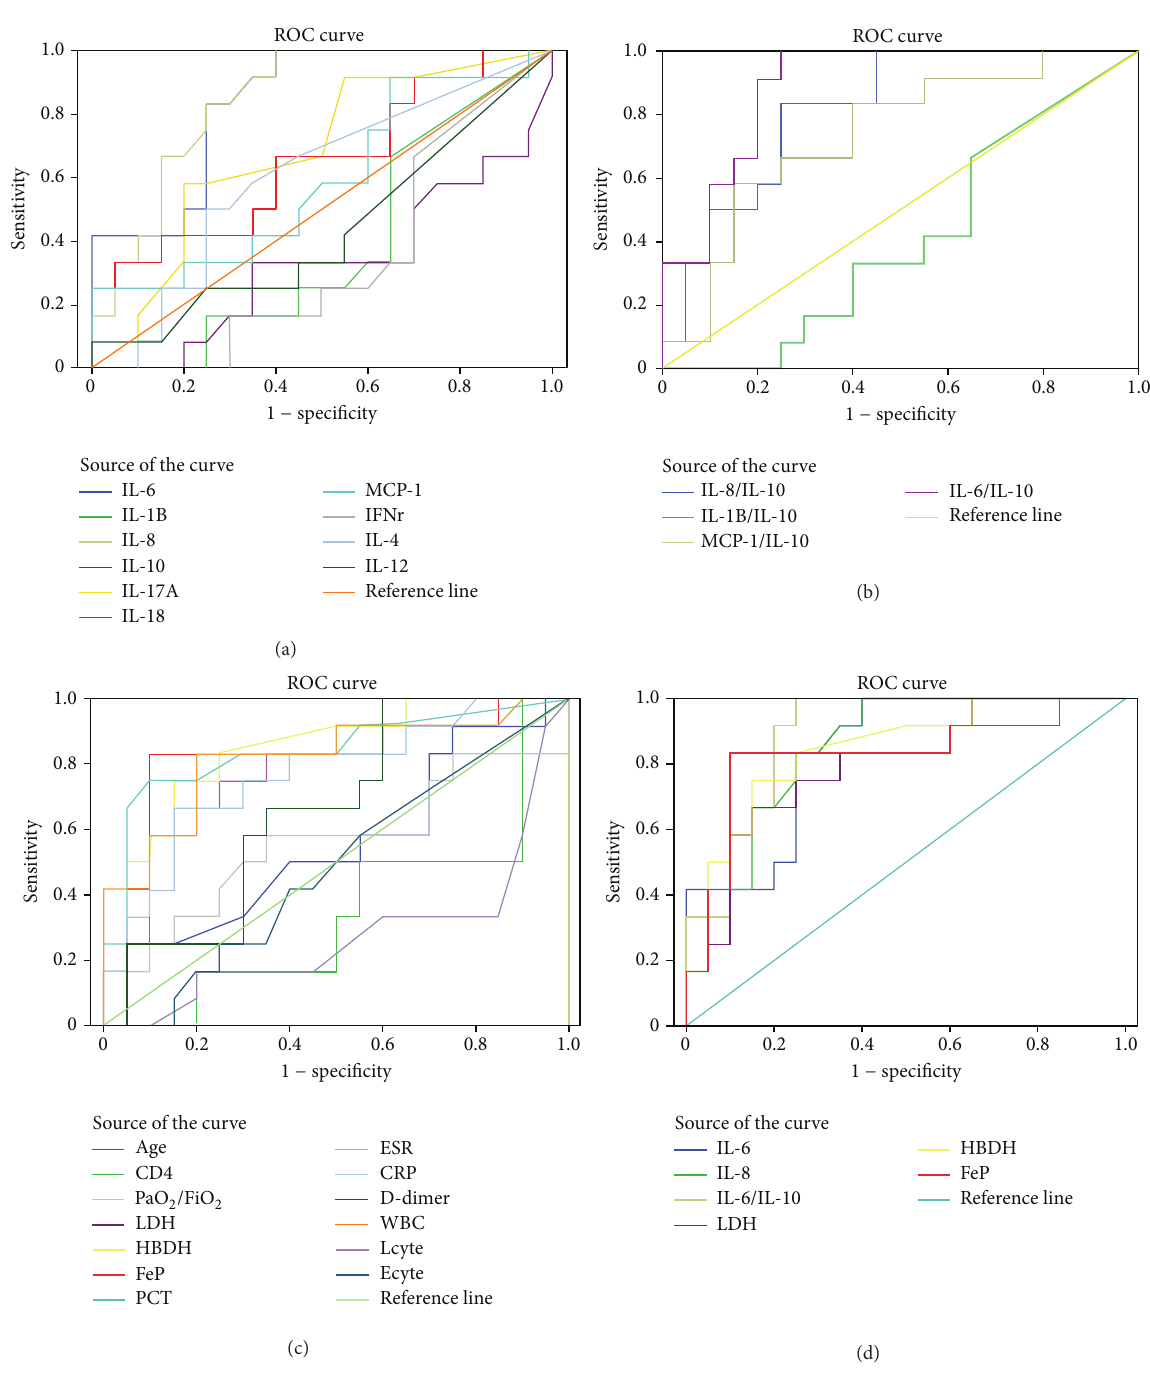
Figure 2: Receiver operating characteristic (ROC) curve analysis of biomarkers in lighter severity (PaO 2 /FiO 2 ≤ 200 mmHg, 𝑁 = 12 ) and heavier severity (PaO 2 /FiO 2 > 200 mmHg, 𝑁 = 20 ) AIDS PCP. (a) LDH (95% CI 0.636–0.956, 𝑃 = 0.006 ), HBDH (95% CI 0.703– 0.985, 𝑃 = 0.001 ), and FeP (95% CI 0.657–0.993, 𝑃 = 0.002 ) showing much higher AUC in severity AIDS PCP groups. (b) IL-6 (95% CI 0.704–0.976, 𝑃 = 0.002 ) and IL-8 (95% CI 0.713–0.978, 𝑃 = 0.001 ) showing much higher AUC in severity AIDS PCP groups. (c) IL-8/IL-10 (95% CI 0.671–0.962, 𝑃 = 0.003 ), MCP-1/IL-10 (95% CI 0.559–0.916, 𝑃 = 0.027 ), and IL-6/IL-10 (95% CI 0.781–1.000, 𝑃 = 0.000 ) showing much higher AUC in severity AIDS PCP groups. (d) Much better six biomarkers’ ROC curves shown together (WBC: white blood